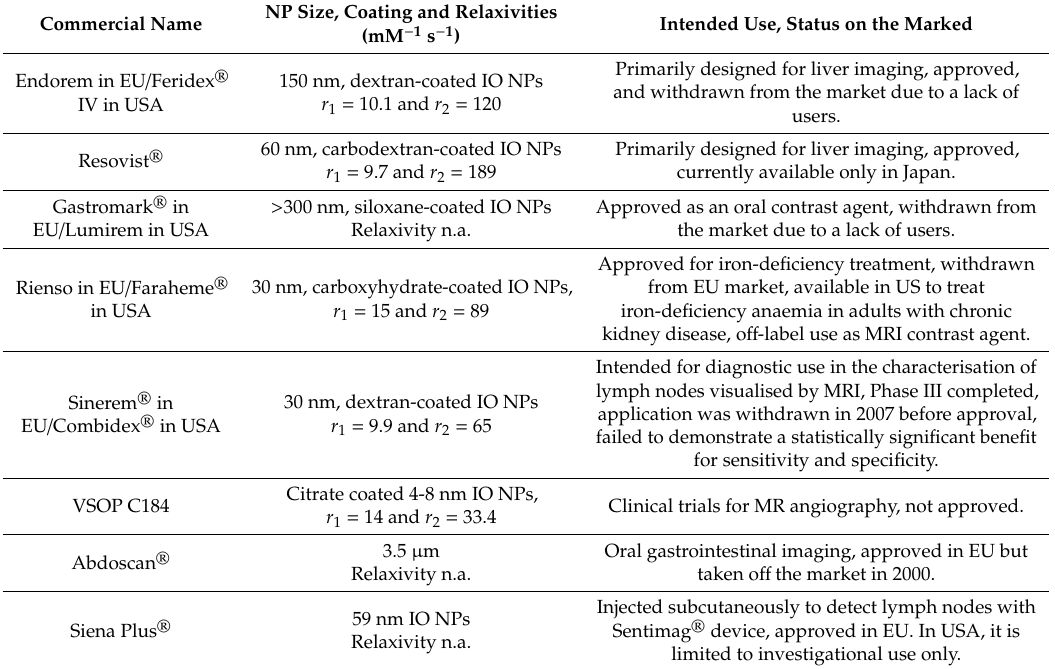
Table 1. List of iron oxide (IO)-based contrast agents that have been clinically approved or entered clinical trials for magnetic resonance (MR) imaging (adapted from [6,8–10]). Relaxivities were measured at 1.5